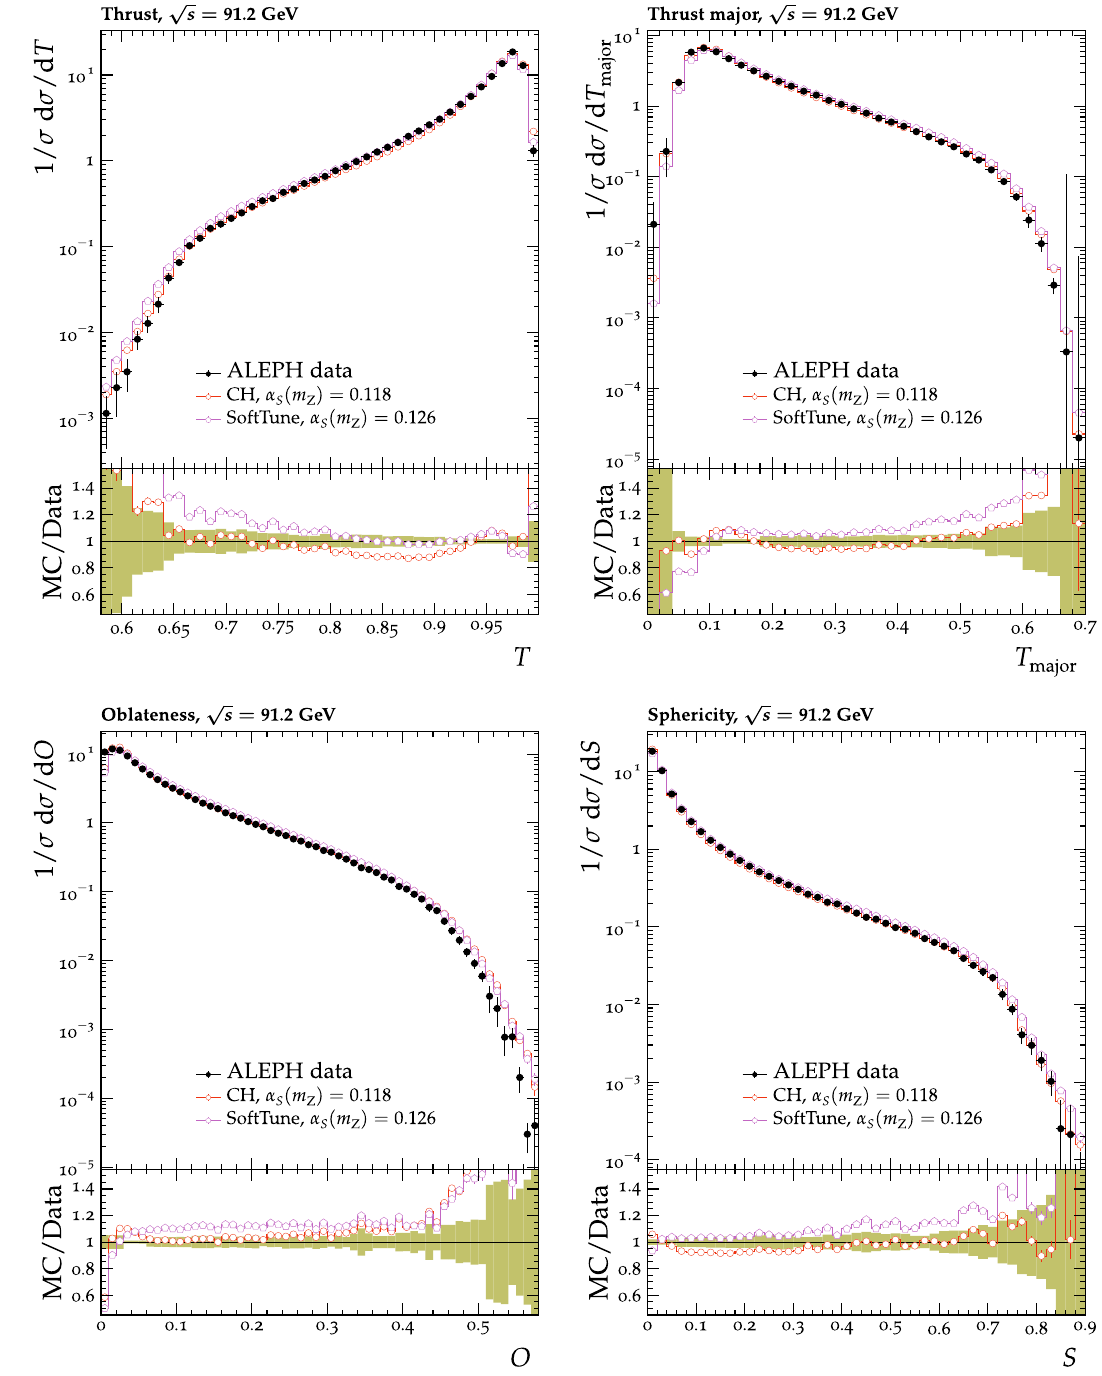
CH tunes. The coloured band in the ratios of the different predictions Fig. 11 Normalizeddifferentialcrosssectionsfore − e + [32]asafunc- tion of the variables T (upper left), T major (upper right), O (lower left), fromsimulationtothedatarepresentsthetotalexperimentaluncertainty √ s = 91 . 2GeV.ALEPHdataare and S (lowerright)forALEPHdataat in the data compared with the predictions from herwig 7 using the SoftTune and 5 Uncertainties in the HERWIG 7